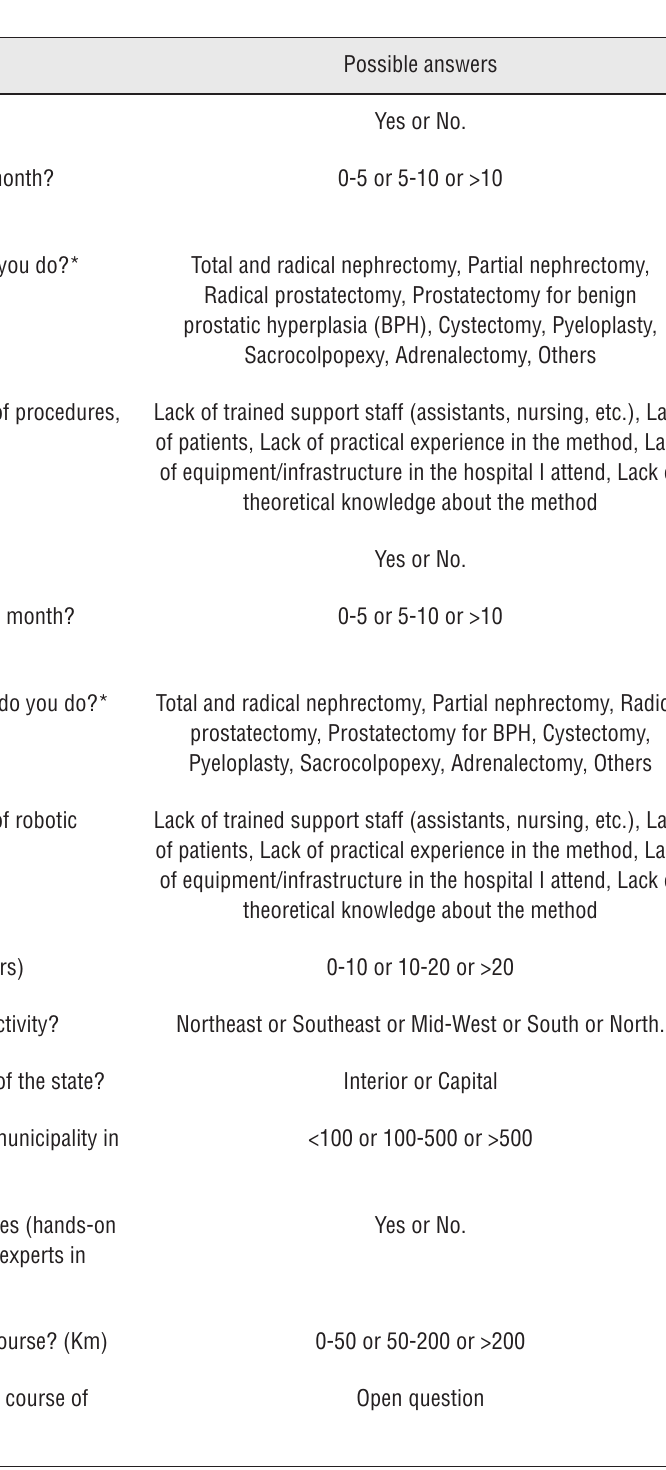
Table 1 - Questions and possible answers sent for SBU